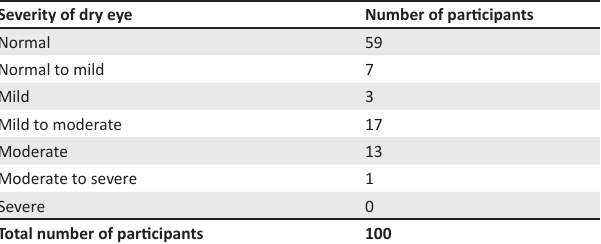
TABLE 1: Ocular surface disease index results for 100 young